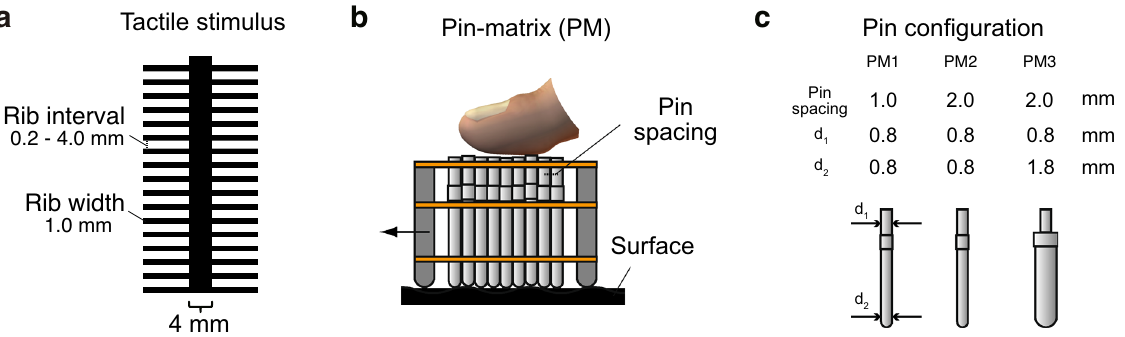
Figure 1. Geometric profile of tactile stimuli used in psychological experiments. ( a ) Geometric configuration of the fishbone tactile illusion (FTI) pattern. This geometry comprises a central strip (the spine of the fishbone) and ribs (adjacent areas). In the experiment, the central strip width was constant, but the interval between ribs was varied to change the perceived stimulus temporal frequency in the adjacent rib areas. ( b ) Schematic of the passive pin matrix. This instrument comprises pins of 0.8 or 1.8 mm in diameter, with a pin spacing of 1.0 or 2.0 mm. The pins can follow the surface geometry beneath the pin matrix in the vertical direction and suppress the horizontal displacement. ( c ) We prepared three pin matrices with multiple pin configurations; d 1 indicates the diameter of the contact area to the fingertip, and d 2 indicates the diameter of the contact area to the surface